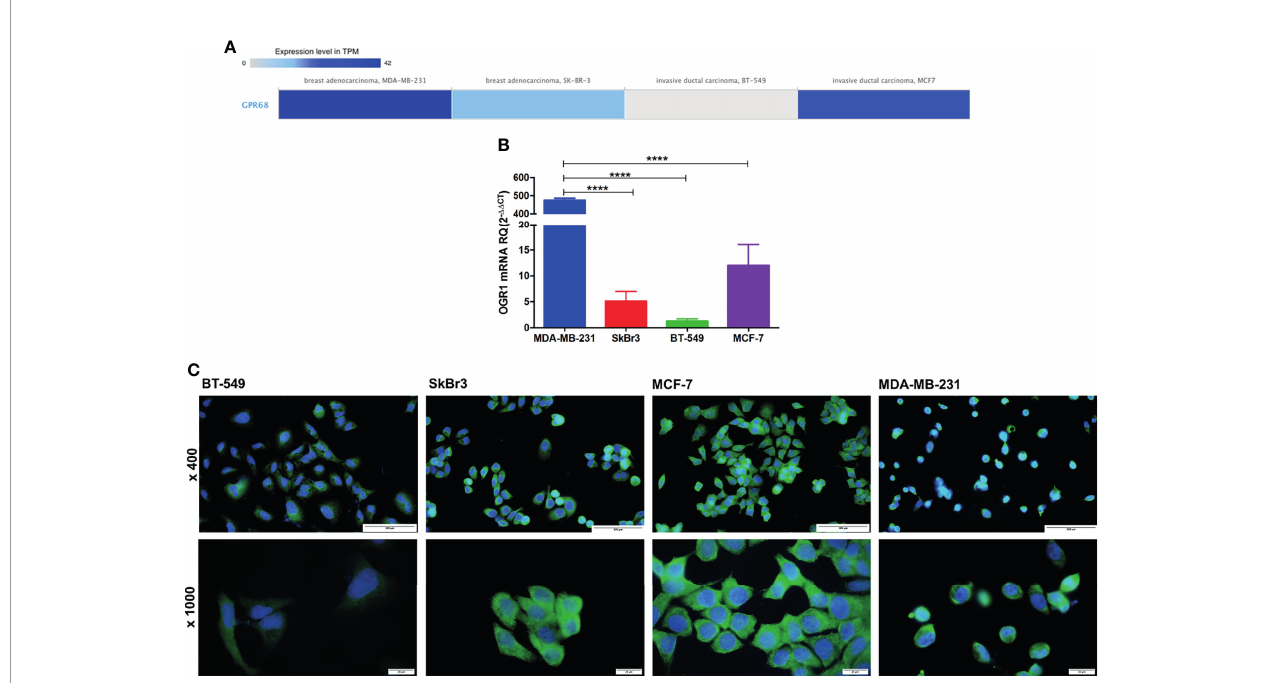
FIGURE 6 | GPR68 expression in breast cancer cell lines. (A) In-silico data showing GPR68 expression in 4 different breast cancer cell lines using the EMBL-EBI tool. The grey color represents the lowest expression while the darkest blue color represents the highest expression. (B) Validation of GPR68 mRNA expression using qPCR in breast cancer cell lines with MDA-MB-231 showing the highest expression. (C) Immuno fl uorescence of GPR68 in breast cancer cell lines, where the blue color indicates the nucleus, and the green fl uorescence represents GPR68 expression. Microscopic images were captured at x400 and x1000 magni fi cation, with a scale bar of 100 and 20 m m, respectively.